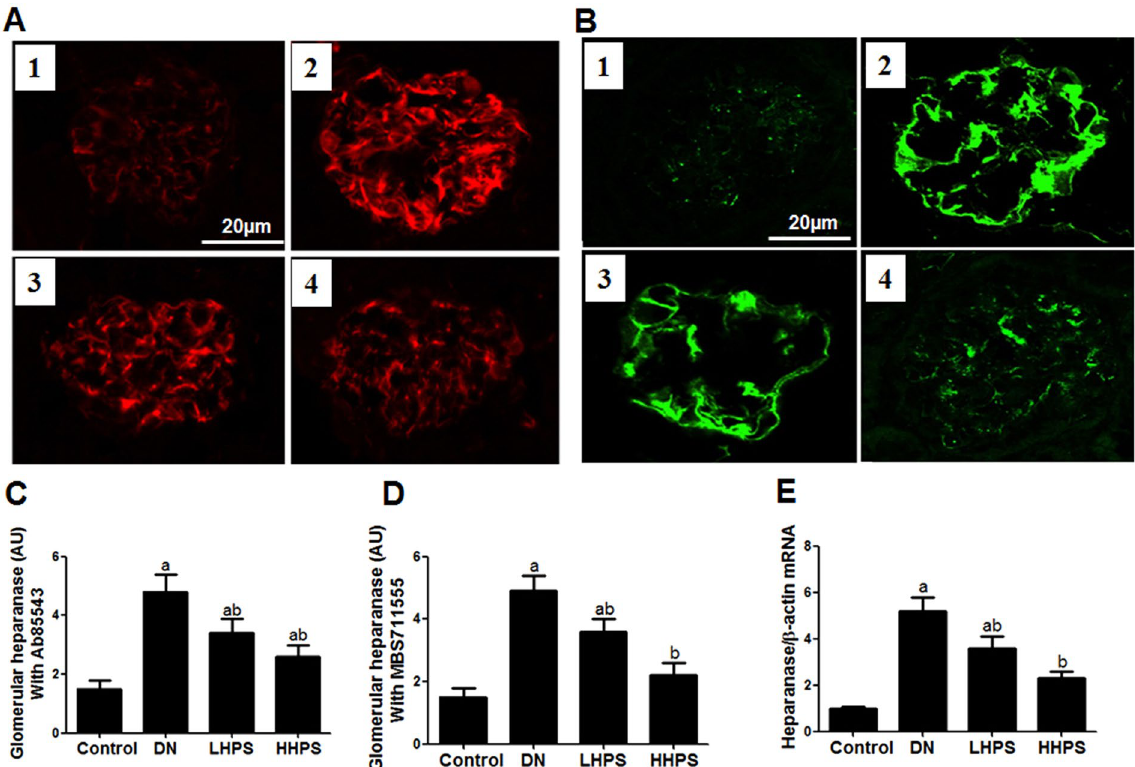
Figure 2. Hyperoside pre-treatment attenuated glomerular heparanase expression in DN mice (n = 5). ( A ) The glomerular heparanase expression was determined by immunofluorescence staining using the heparanase primary antibody (Ab85543) detecting 65 kD precursor as well as the 50 kD and 8 kD subunits of heparanase followed by rhodamine conjugated secondary antibody. ( B ) The heparanase primary antibody (MBS71555) followed by FITC conjugated secondary antibody was used to show 65 kD heparanase. 1:Control; 2:DN; 3:LHPS; 4:HHPS. ( C , D ) Quantification was performed by NIH Image software and shown in columns. ( E ) The columns showed the amount of heparanase mRNA levels relative to β -actin. Data are presented as mean ±